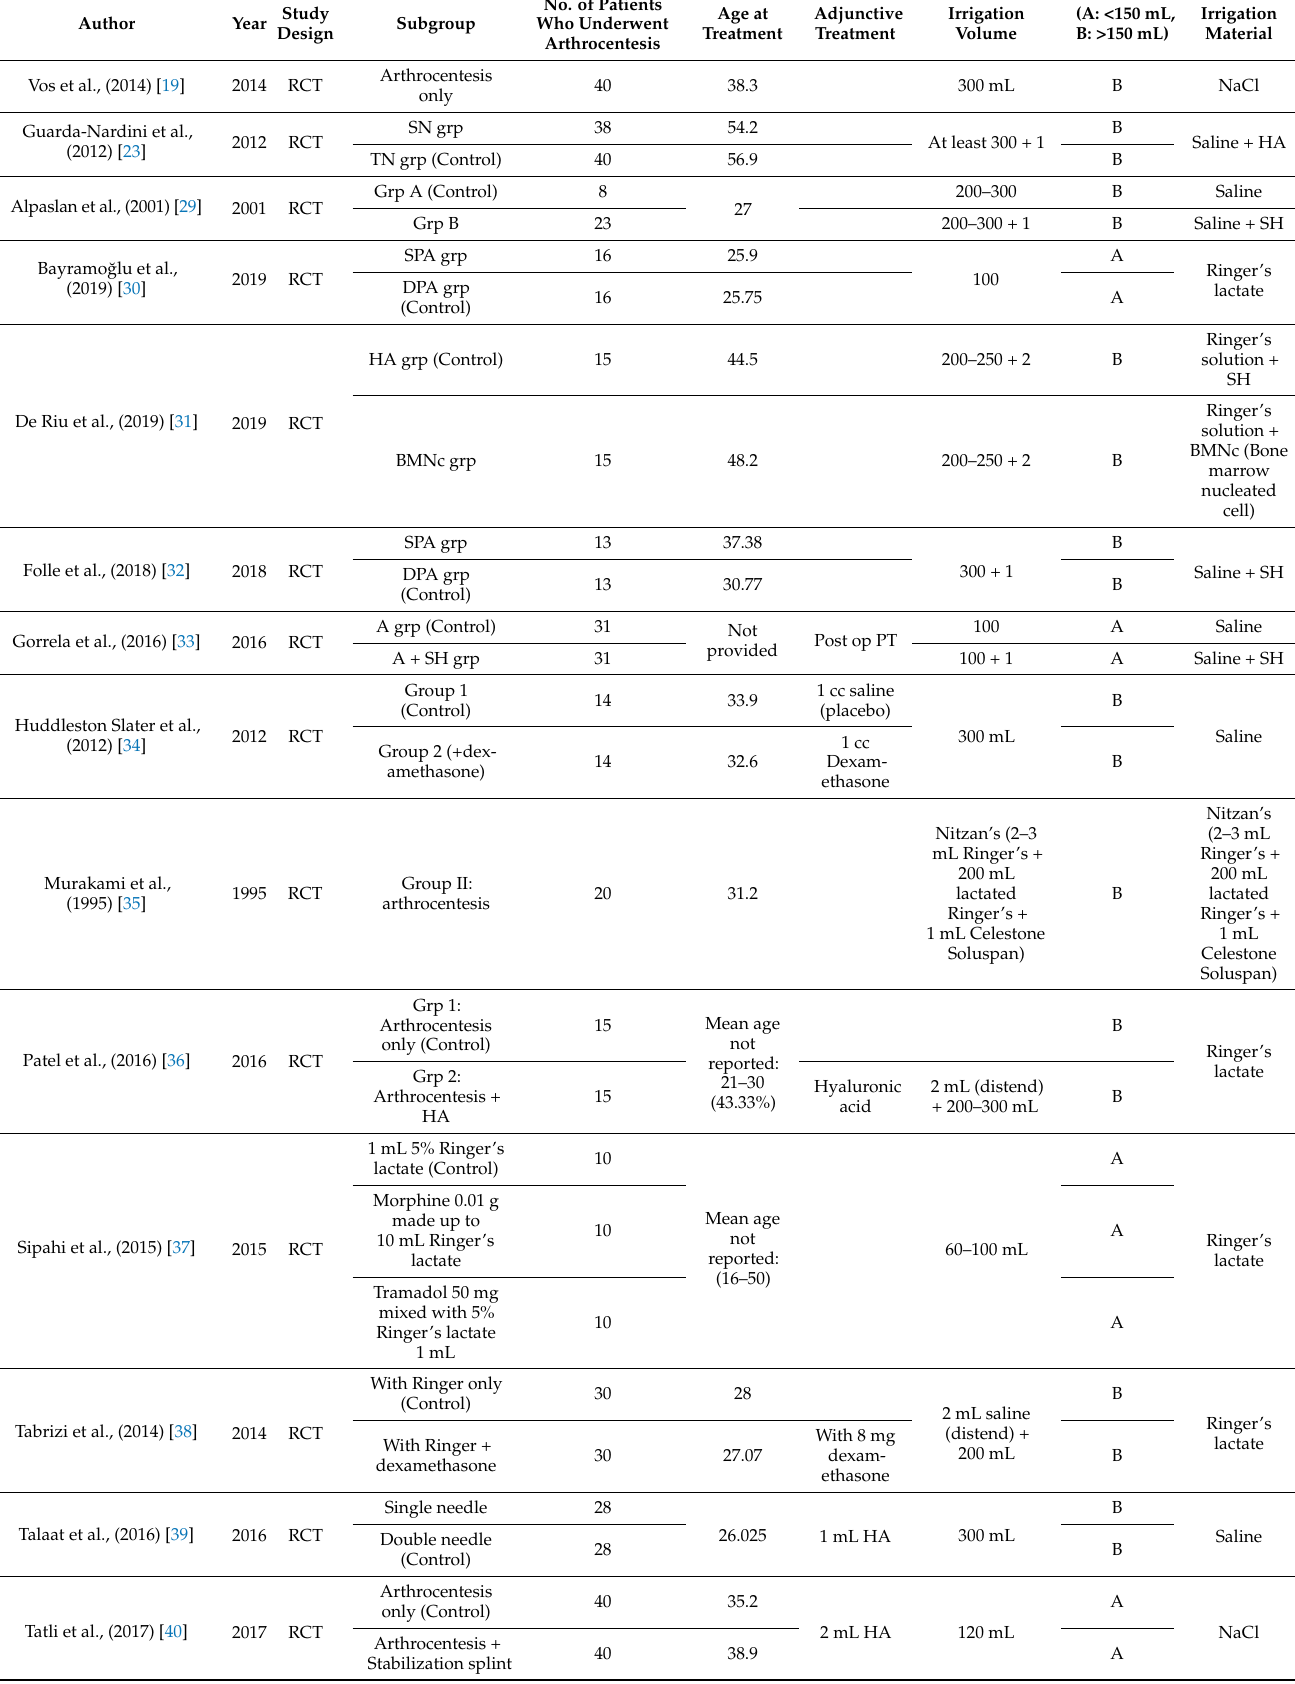
Table 1. Details of the studies